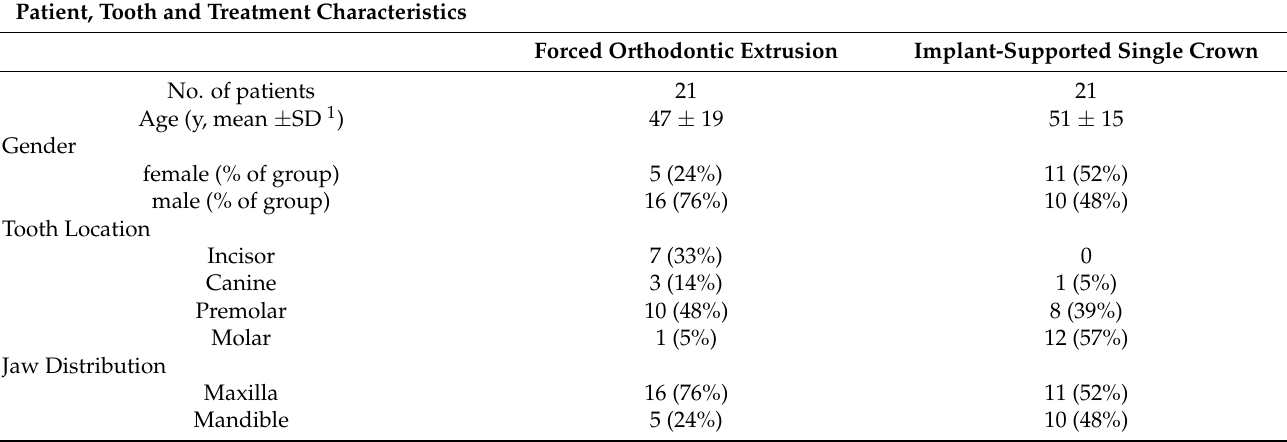
Table 1. Descriptive data for participants and tooth